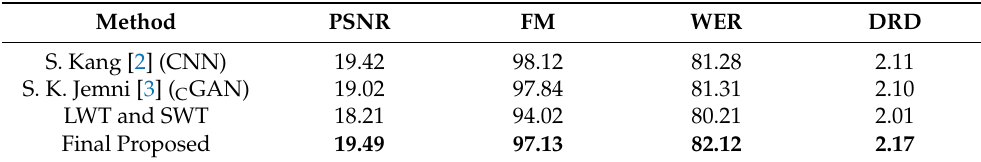
Table 4. Comparative results on Blurry document images dataset